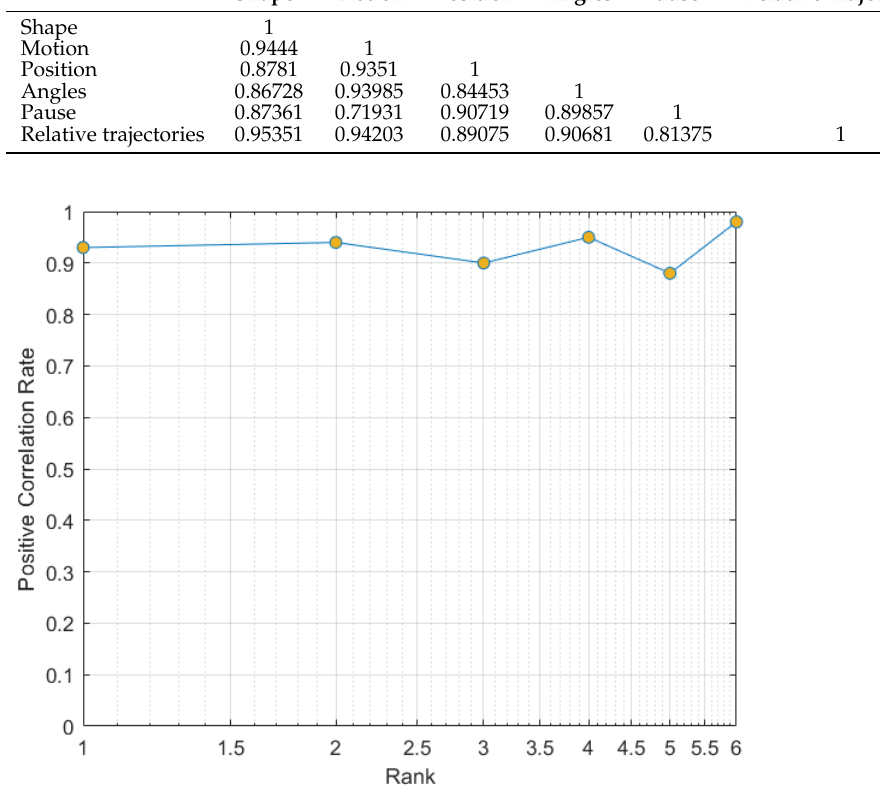
Figure 4. Cumulative match characteristics curve of the features from